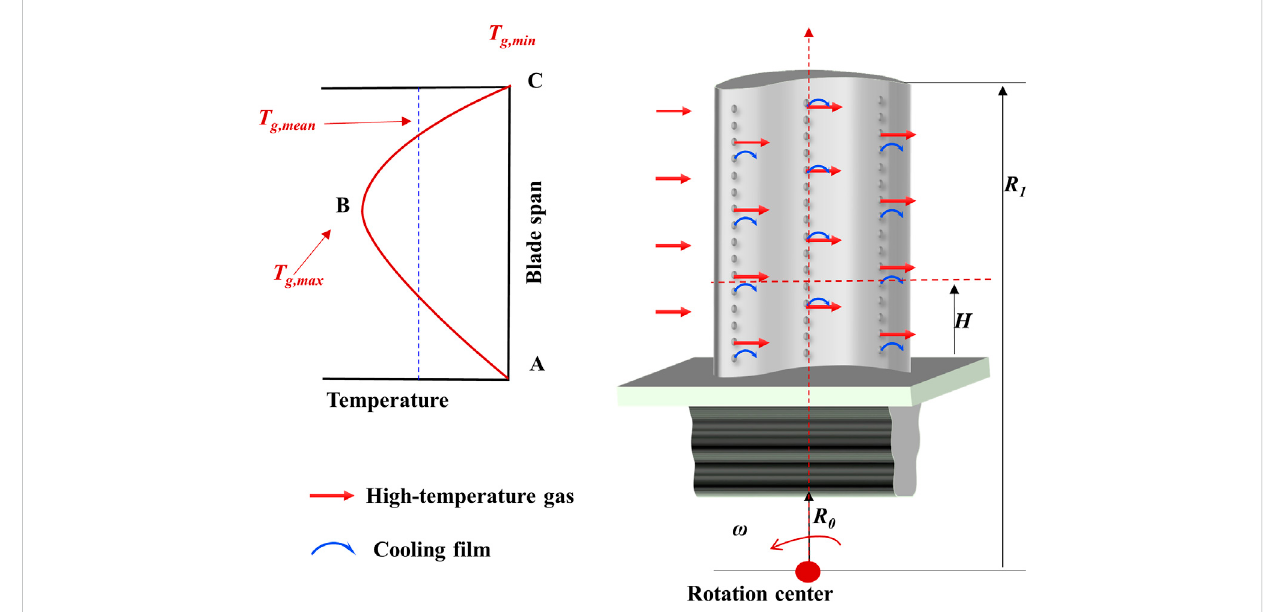
FIGURE 1 Schematic of the model assisted in calculating the temperature and stress distribution of the DZ125 blade in service.